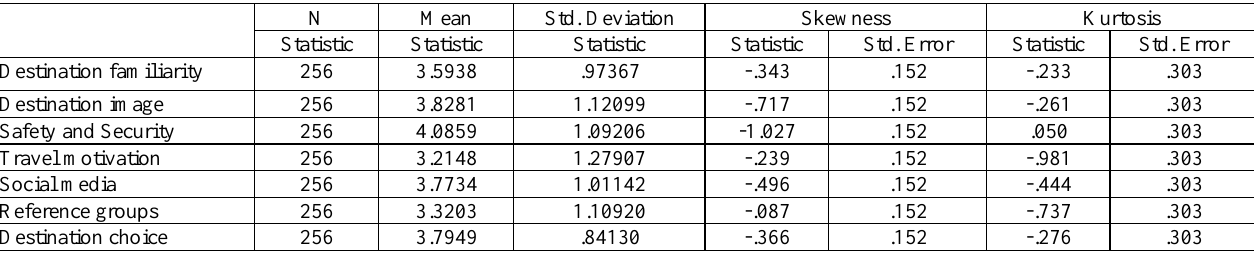
Table 2. Descriptive statistics analysis